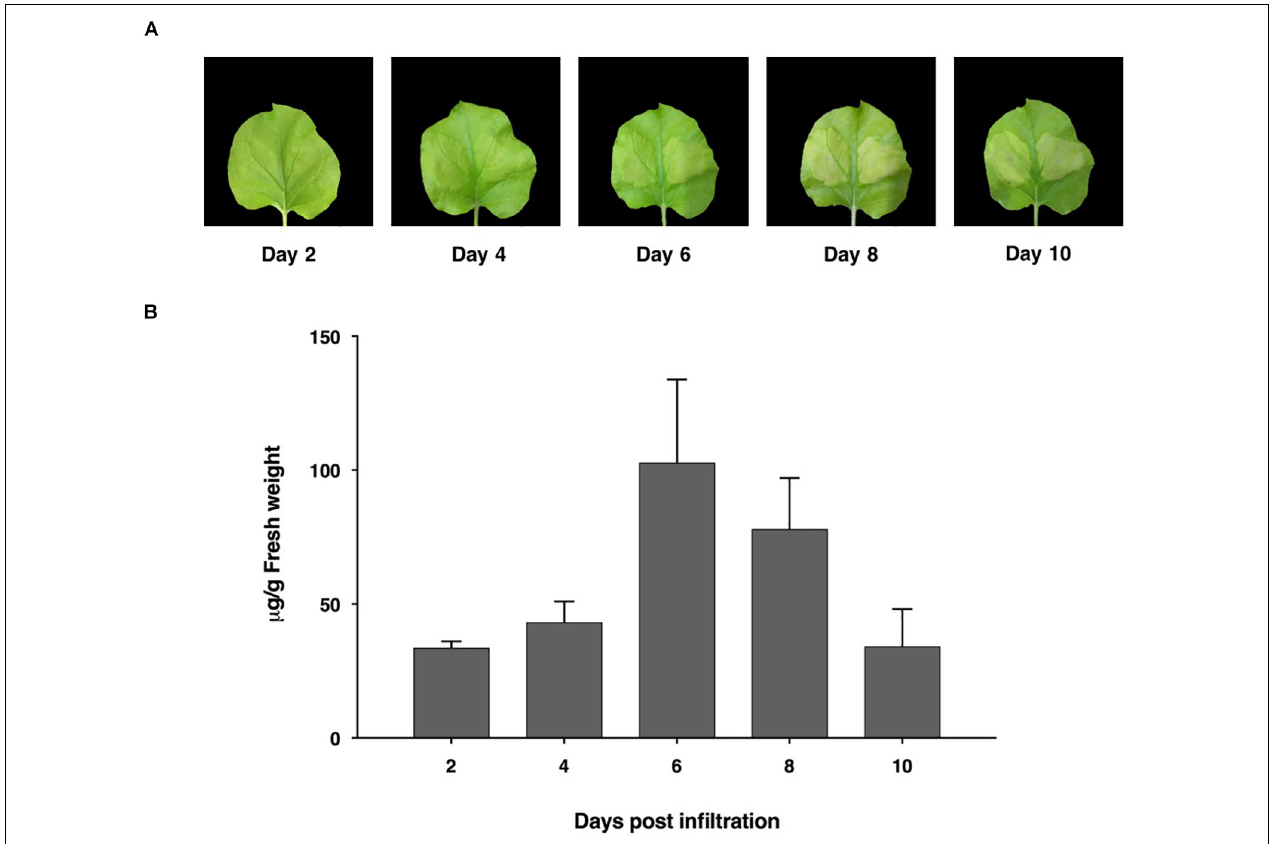
FIGURE 2 | Expression profiles of ACE2-Fc in N. benthamiana leaves on days 2, 4, 6, 8, and 10 after agroinfiltration. Leaf necrosis (A) Quantification of plant-produced ACE2-Fc (B) . The infiltrated leaves were collected from 3 individual plants in each day post infiltration. Data were analyzed by indirect ELISA assay using ACE2-specific antibody and presented as mean ± SD of